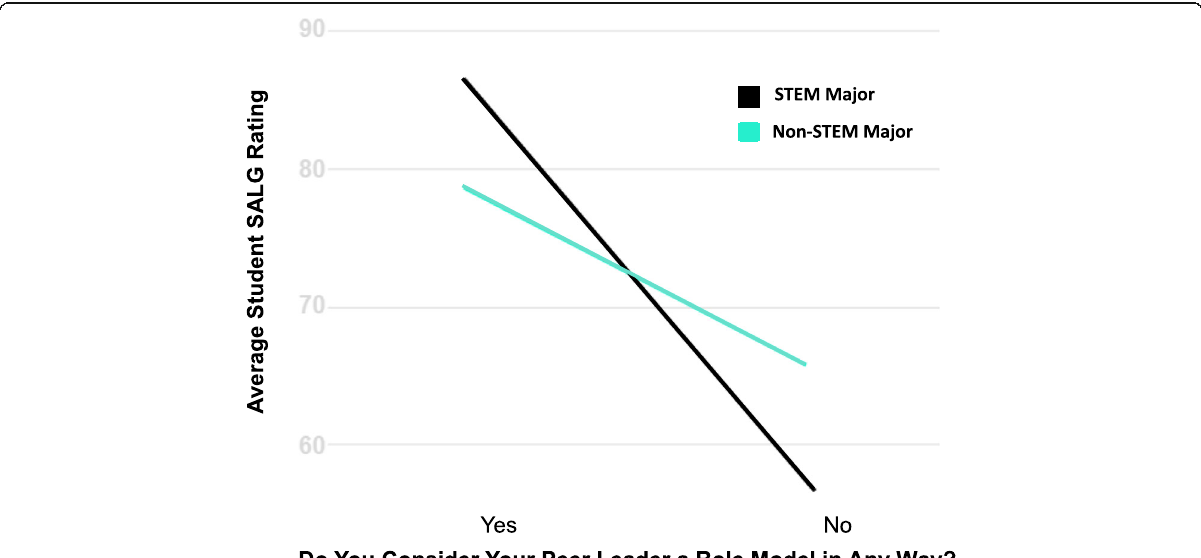
Fig. 3 Interaction of student major and peer leader role model status on student perceived learning gains. This figure illustrates the trend that a peer leader who is considered to be a role model by their students has a stronger yet statistically insignificant ( p = .092) association with the student perceived learning gains of STEM majors as compared to non-STEM majors